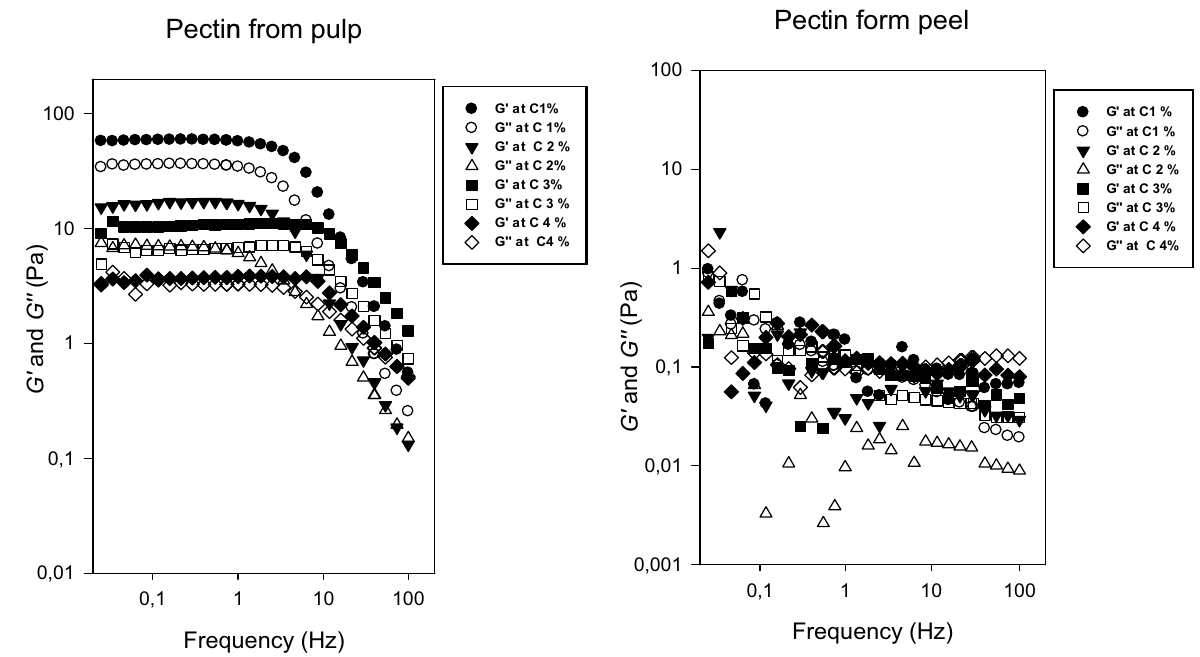
Figure 7: Storage modulus ( G ′ ) and loss modulus ( G ″ ) as a function of angular frequency of pumpkin pectin extracted from pulp and peel solubilized at various concentrations in 0.2 M citric acid/sodium citrate at 20°C.